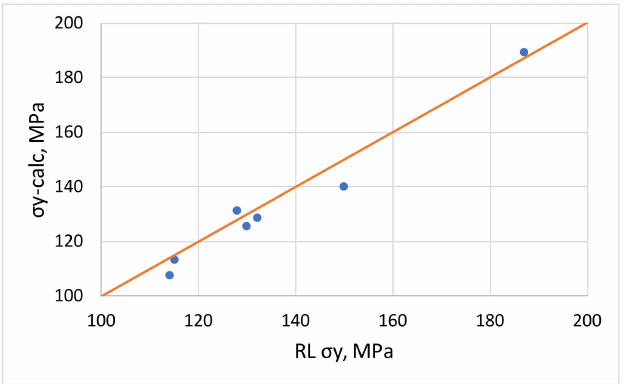
Figure 9. Comparison of calculated and measured yield stress